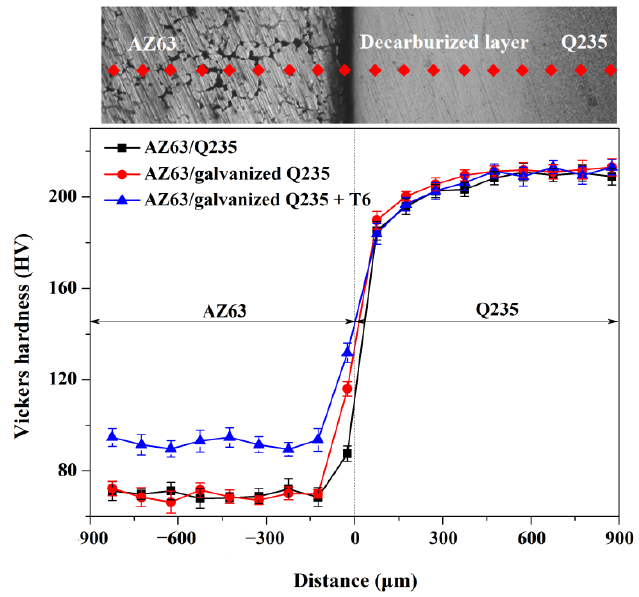
Figure 12. The microhardness distributions across the interface of the AZ63/Q235, AZ63/galvanized Q235, and AZ63/galvanized Q235 +